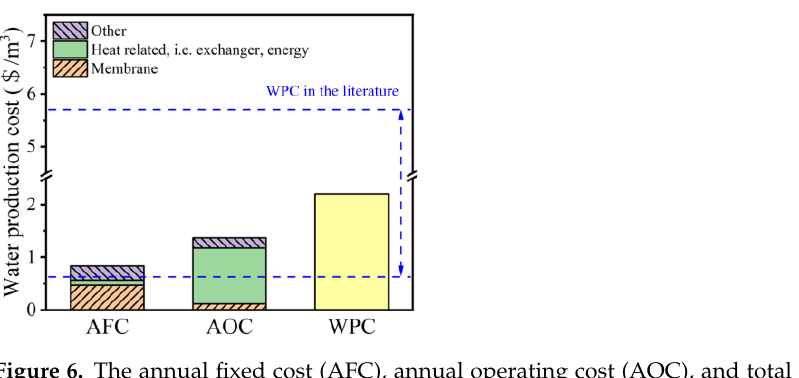
Figure S3: SEM-EDS coupled determination of fouled membrane (a) PVDF and (b) PVDF-CNT-FAS surface elements; Table S1: Assumption parameters and specific costs in economic analysis; Table S2: Fixed and Operating cost per cubic meter of shale gas wastewater treatment